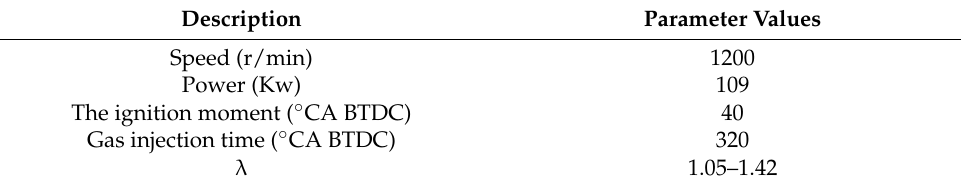
Table 3. Setting of test condition